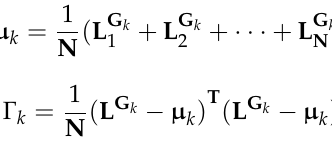
Figure 5. Illustration of low-rank and sparse decomposition.